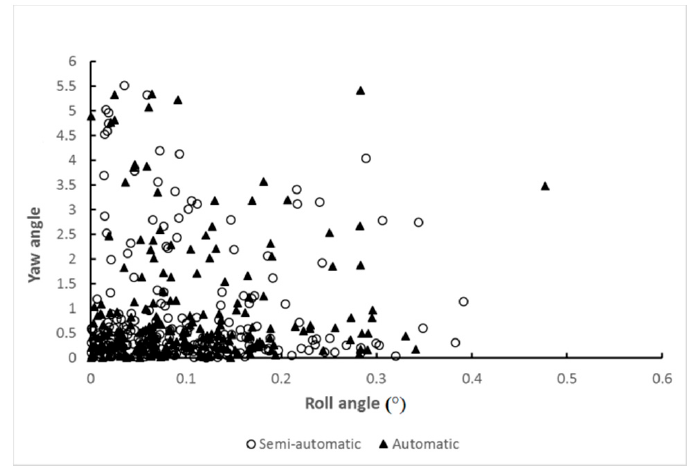
Figure 11. Consistency of the yaw and roll angle results. Each point represents a case, where the x- and y-axes are the roll and yaw angles, respectively (circles: semi-automatic; triangles: automatic).